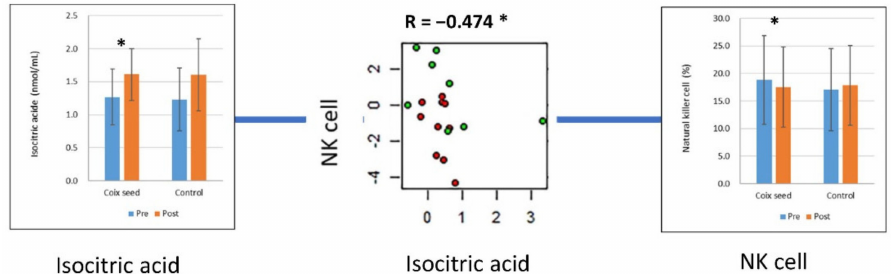
Figure 5. Isocitric acid and its correlation with the natural killer cell percentage. The plasma concentration of isocitric acid significantly increased with coix seed consumption. The change in isocitric acid showed a significant correlation with the change in natural killer (NK) cell percentage. In the scatter plot, the red and green circles denote the coix seed consumption group and the control group, respectively. In the bar graphs, the blue and orange bars denote before (pre-intervention) and after (post-intervention) coix seed consumption, respectively. *, p <